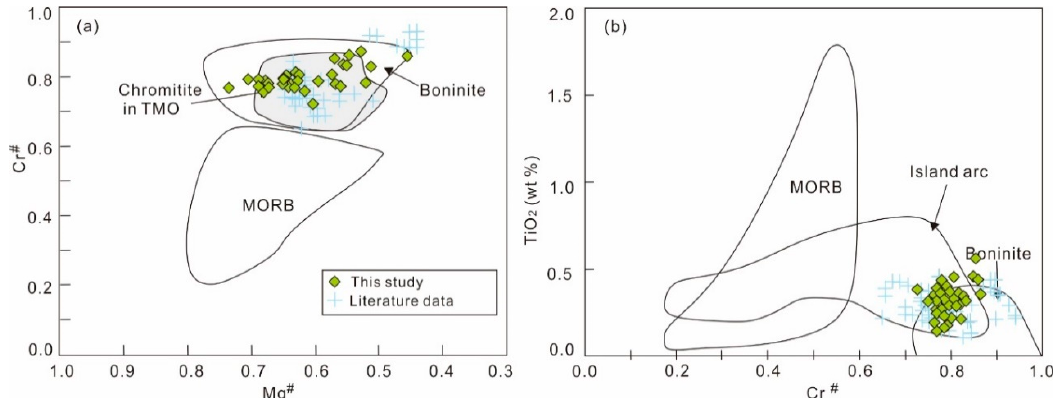
Figure 5. ( a ) Variations in chrome spinel Mg# versus Cr# (based on Xiong et al. [45]) and ( b ) spinel Cr# versus TiO 2 (wt.%) diagrams. Literature data for the Jijal chromitite are from Arif and Jan [34].